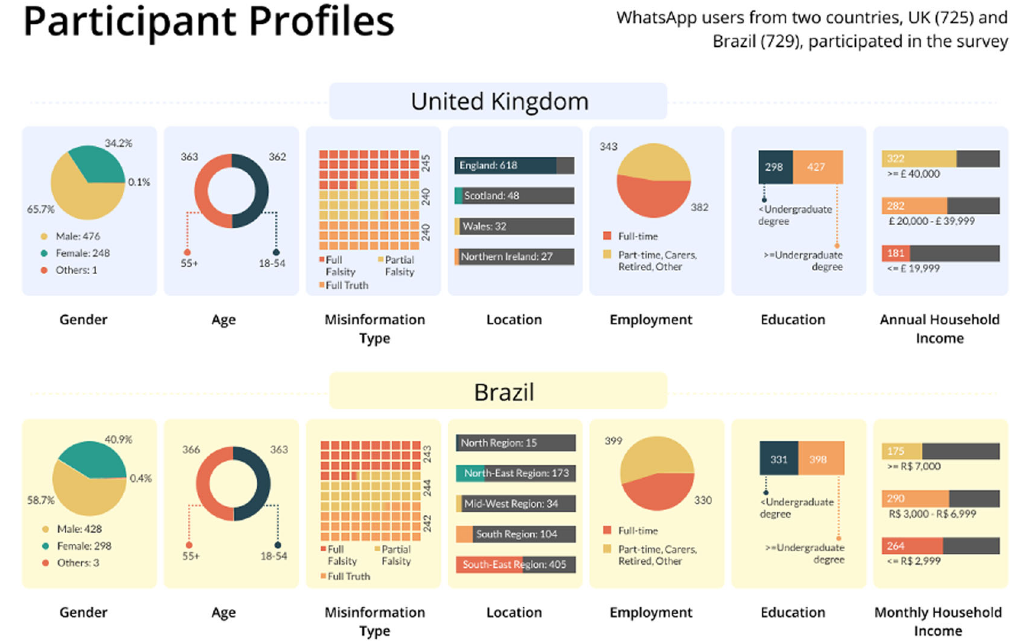
Fig. 2 Participant pro fi le. Sociodemographic breakdown of study participants in the UK and Brazil.